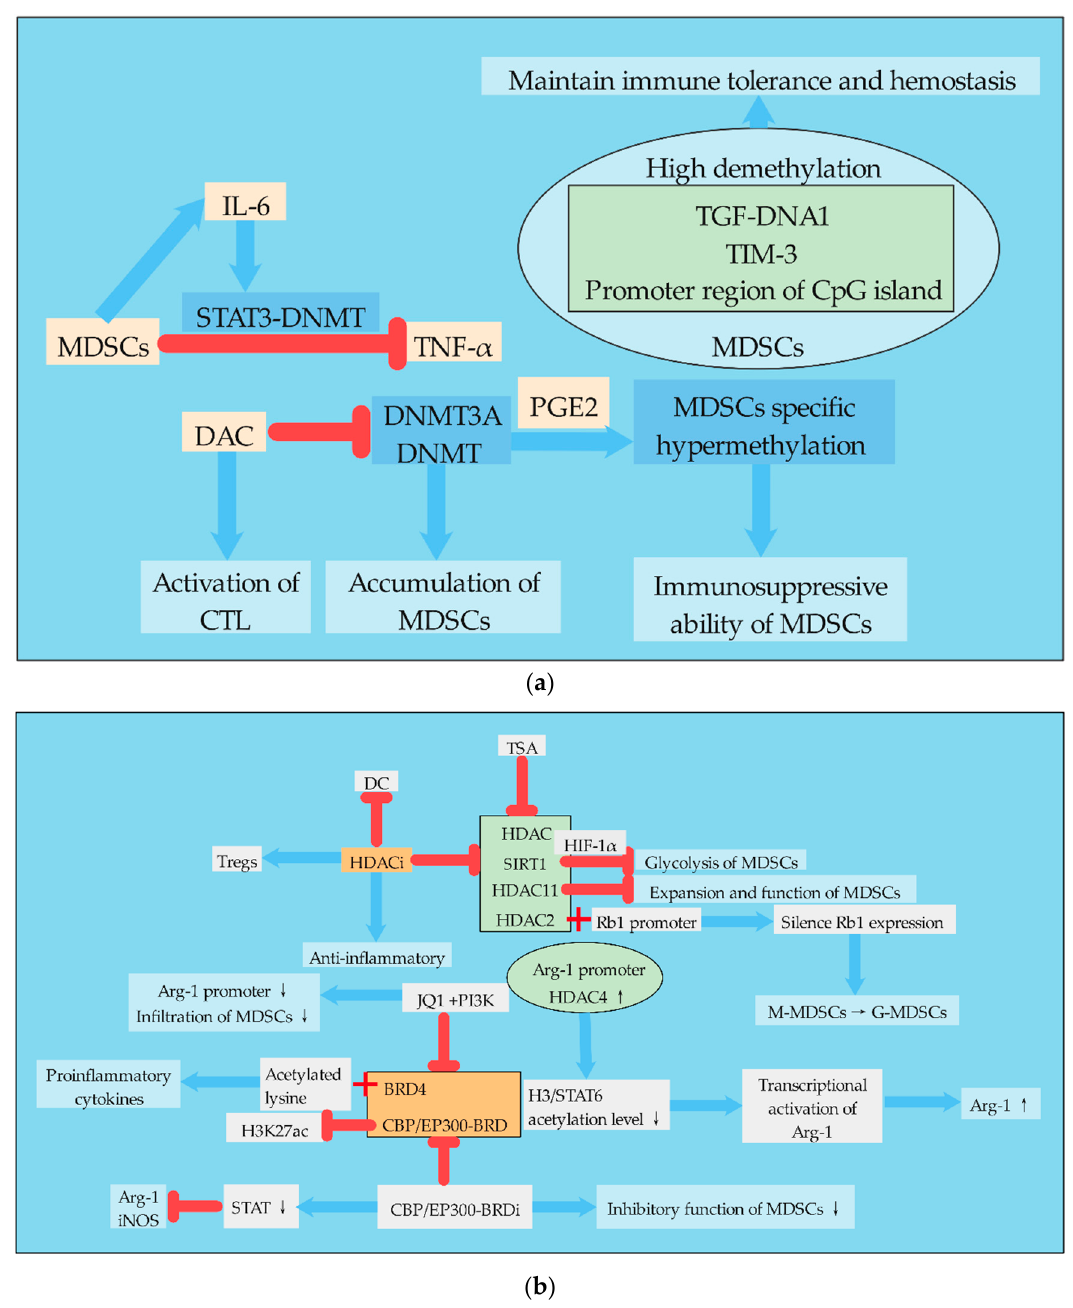
Figure 3. Regulation of epigenetic modification in MDSCs. ( a ). MDSCs can activate the STAT3-DNMT epigenetic axis through autocrine IL-6 to inhibit TNF- α and promote tumor development. High demethylation of TGF-DNA1 / TIM-3 / CpG island promoter region in MDSCs is of great significance for the maintenance of immune tolerance and hemostasis. DAC can inhibit DNMT and thus the accumulation of MDSCs. DCA can also activate CTL directly. In the presence of PGE2, DNMT3A can promote MDSC-specific hypermethylation. ( b ). Histone acetylation plays an important role in the amplification of MDSCs. The regulation of MDSCs by histone acetylation is mainly realized by the dynamic balance between HATs and HDAC. TSA and HDACi inhibit HDAC. Moreover, HDACi can inhibit DCs and increase the number of Tregs, which has anti-inflammatory e ff ects. HDAC11 can inhibit the amplification and function of MDSCs. The binding of HDAC2 and Rb1 promoter leads to Rb1 silencing and promotes the di ff erentiation of M-MDSCs into G-MDSCs. Arg-1 is a key inhibitory molecule in MDSCs. The increase in HDAC4 in the promoter region of Arg-1 can lead to the decrease in acetylation level of H3 / STAT6, thus promoting the transcriptional activation of Arg-1. BRD4 and CBP / EP300-BRD can inhibit histone acetylation and promote the production of proinflammatory factors. CBP / EP300-BRDi can inhibit CBP / EP300-BRD, leading to a decline in the inhibitory function of